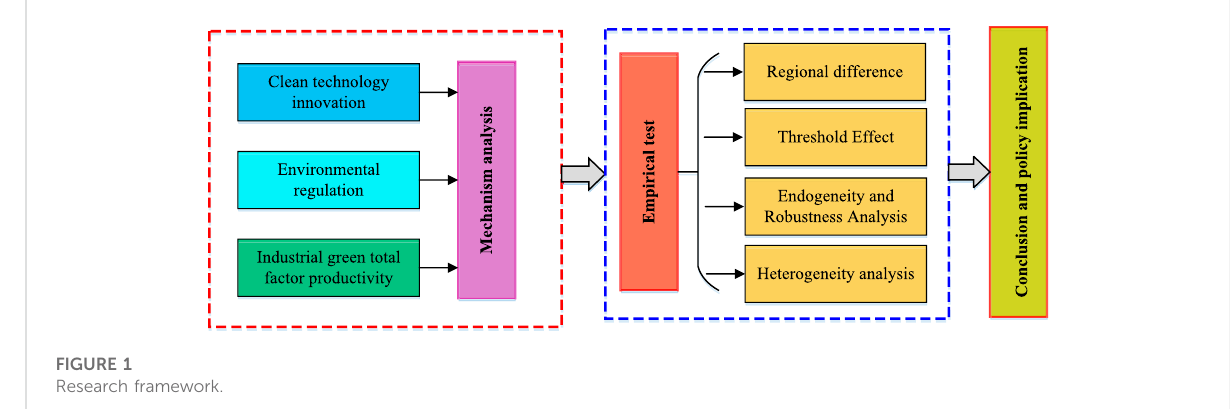
FIGURE 1 Research